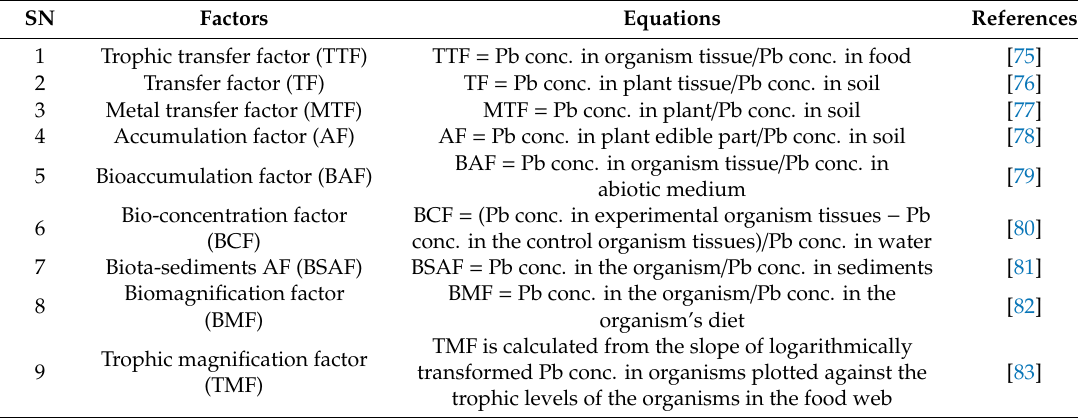
Table 2. Di ff erent indices used to quantify Lead toxicity at trophic levels in the food chain